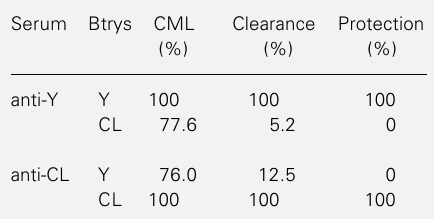
Table 1 - Ability of antisera to Y or CL bloodstream trypomastigotes (Btrys) to induce homologous or heterologous complement-mediated lysis (CML), clearance and